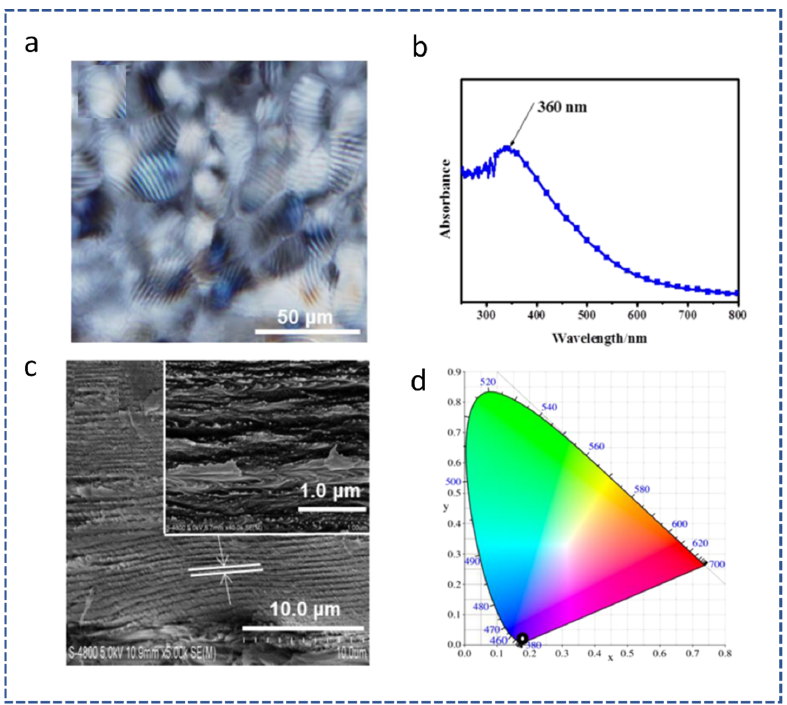
Figure 5. ( a ) polarized optical microscopy (POM) images of the CNC suspension that contained an increasing CNC concentration during the evaporation process. ( b ) UV − vis absorbance spectra of the CNC iridescent film show a maximum reflection point of 360 nm that determines how the colour of the development is perceived by the naked eye. ( c ) Field emission scanning electron microscopy (FE-SEM) images of the CNC iridescent film. ( d ) Commission on Illumination (CIE) chromaticity diagram of the CNC film. Adapted with permission from Ref [178]. Copyright 2020 American Chemical Society.